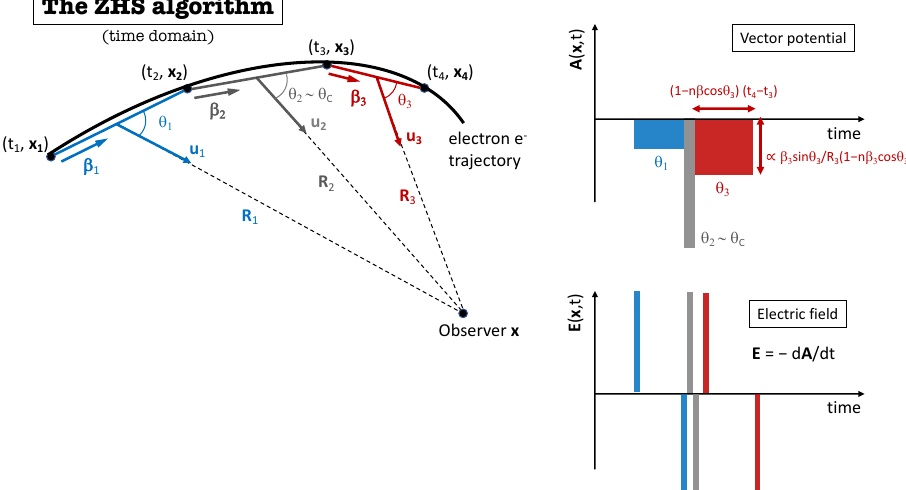
Figure 1. Schematic representation of a particle trajectory with sub-track division prepared for the ZHS algorithm. The corresponding results of the ZHS Equation (8) in the time domain for the vector potential are illustrated on the top right, and its time derivative Equation (2), directly proportional to the electric field, in the bottom right. Sub-tracks are naturally obtained in a simulation when the particle interacts changing its momentum. The sub-tracks are considered uniform and rectilinear motions. As particles have continuous energy loss and multiple elastic scattering, an average velocity is taken for each sub-track. When continuous changes in velocity are large between interactions, the interval is further divided into smaller sub-tracks to improve the